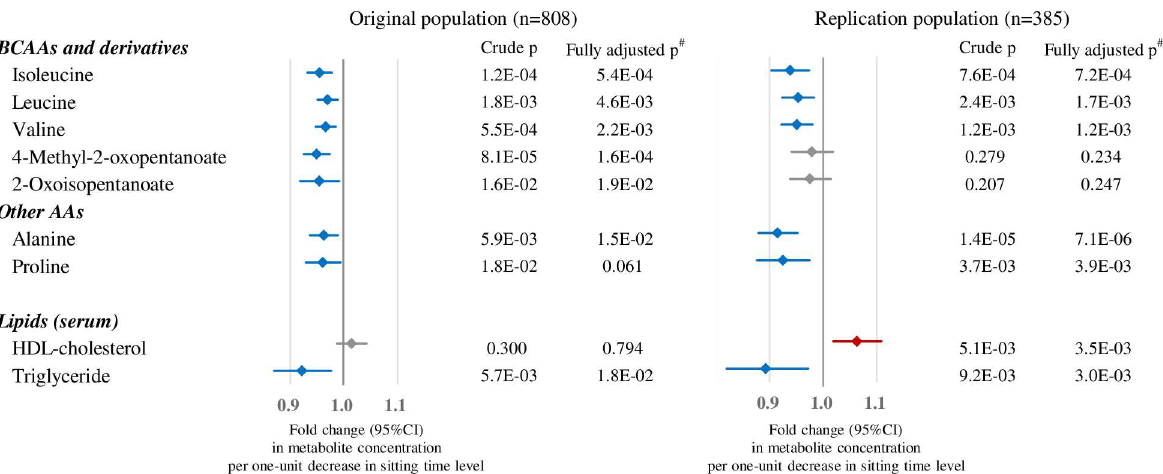
Fig 3. Associations between sedentary behavior level and metabolite measurements. Associations between metabolites and sitting time level (long, medium, short) in the original(left) and replication(right) populations. Linear regressionbetween each metabolite was performed, and p-values for unadjustedand adjusted models are shown. Fold change per one-unitdecrease with 95% CI in sitting time level were calculated using the beta of the linear regressionanalysisof the unadjustedmodel. Blue bars mean lower concentrations in the shorter sitting time groups. Only metabolites associated with sitting time levels (p < 0.05 for the unadjusted model in the originalpopulation) among metabolites associatedwith TPA (shown in Fig 2) are shown. # Adjusted for age, BMI, smoking (never/ former/current), current alcohol drinker (yes/no), and energy intake